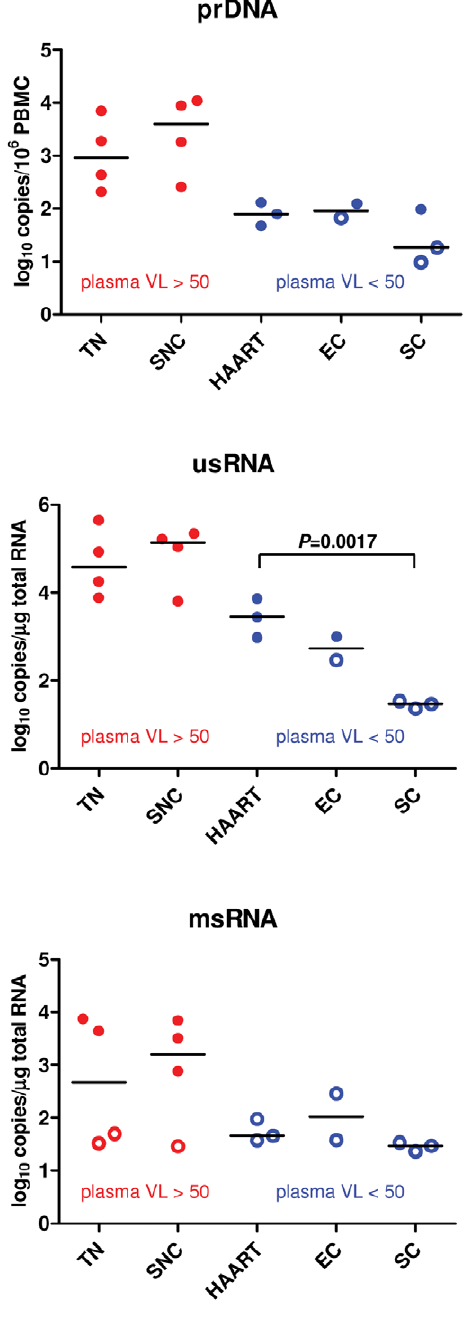
Figure 1. Levels of intracellular HIV-1 molecular markers in PBMC. Levels of proviral DNA (prDNA), unspliced RNA (usRNA), and multiply spliced RNA (msRNA) are shown. Patient groups with detectable plasma viremia (TN and SNC) are shown in red, and those with undetectable plasma viremia (HAART-treated, EC, and SC) are shown in blue. Horizontal bars represent median values. Undetectable values, left-censored at the corresponding detection limits (which were different for every sample, as they depended on total cellular inputs in the real-time PCR reactions), are depicted by open circles. Individual prDNA and usRNA values are means of two independent measure- ments. The statistical significance of the comparison between usRNA levels of SC and HAART-treated patients was calculated by use of